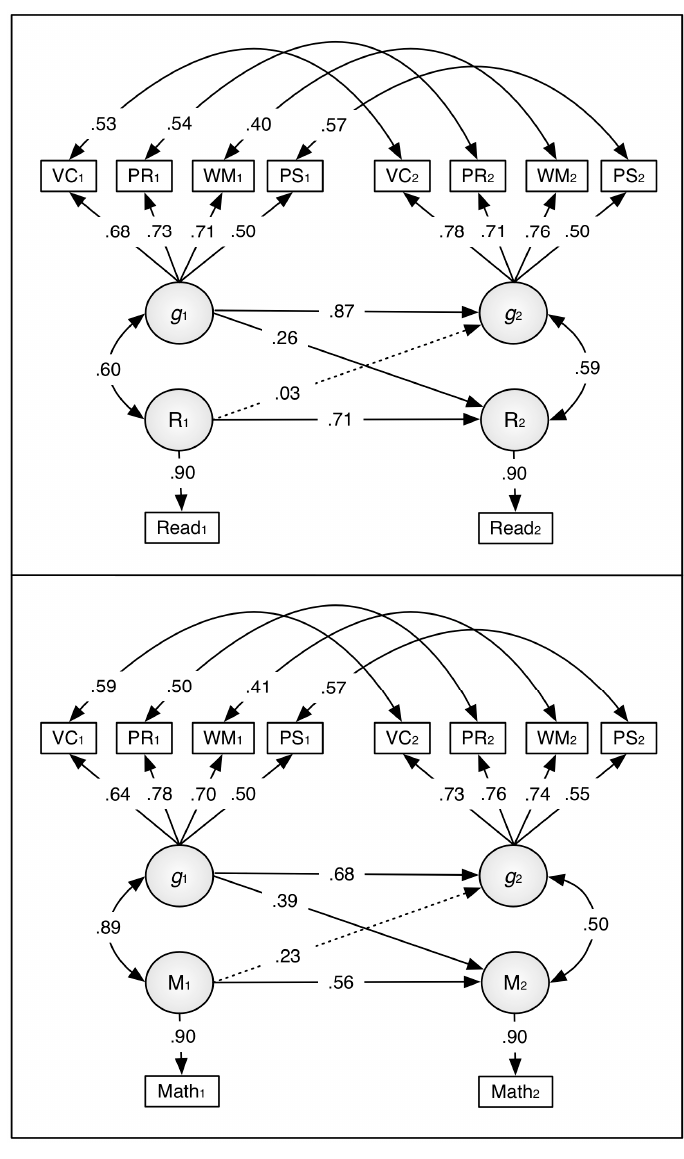
Figure 1. Cross-lagged panel model of intelligence measured by the Wechsler Intelligence Scale for Children-Fourth Edition (WISC-IV) and achievement in reading (upper panel) and math (lower panel) for 337 students twice tested for special education eligibility across a 2.85 year interval. Note: VC = Verbal Comprehension Index, PR = Perceptual Reasoning Index, WM = Working Memory Index, PS = Processing Speed Index, g = General Intelligence, R = reading factor, Read = reading composite score, M = math factor, and Math = mathematics composite score. Numerical subscript indicates test (time 1) or retest (time 2) occasion. Standardized coefficients with error/disturbance terms omitted for visual clarity. Nonsignificant paths are dotted.